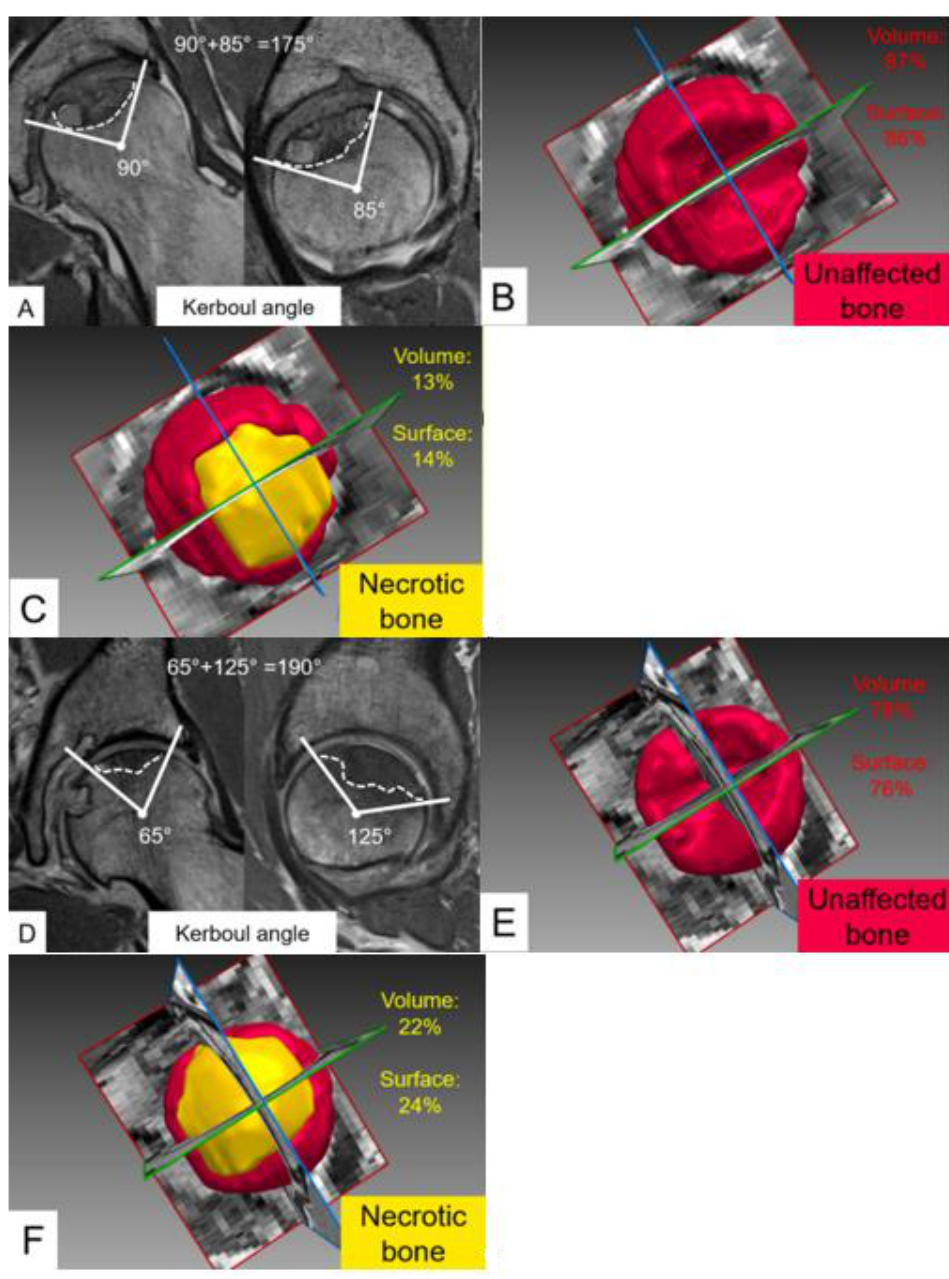
Figure 3. Quantification of femoral head necrosis with modified Kerboul angles and 3D quantification using fully automated 3D models of the femoral head in two different patients. ( A – C ) 43-year-old man and ( C – F ) 36-year-old woman with advanced femoral head necrosis (ARCO 3A) and comparable Kerboul angles of ( A ) 175° and ( D ) 190°. In contrast, marked differences were observed between both patients for ( C , F ) relative necrotic volume (13% versus 22%) and relative necrotic surface area (14% versus 24%), underlining the potential of deep learning-based 3D quantification to improve surgical planning.